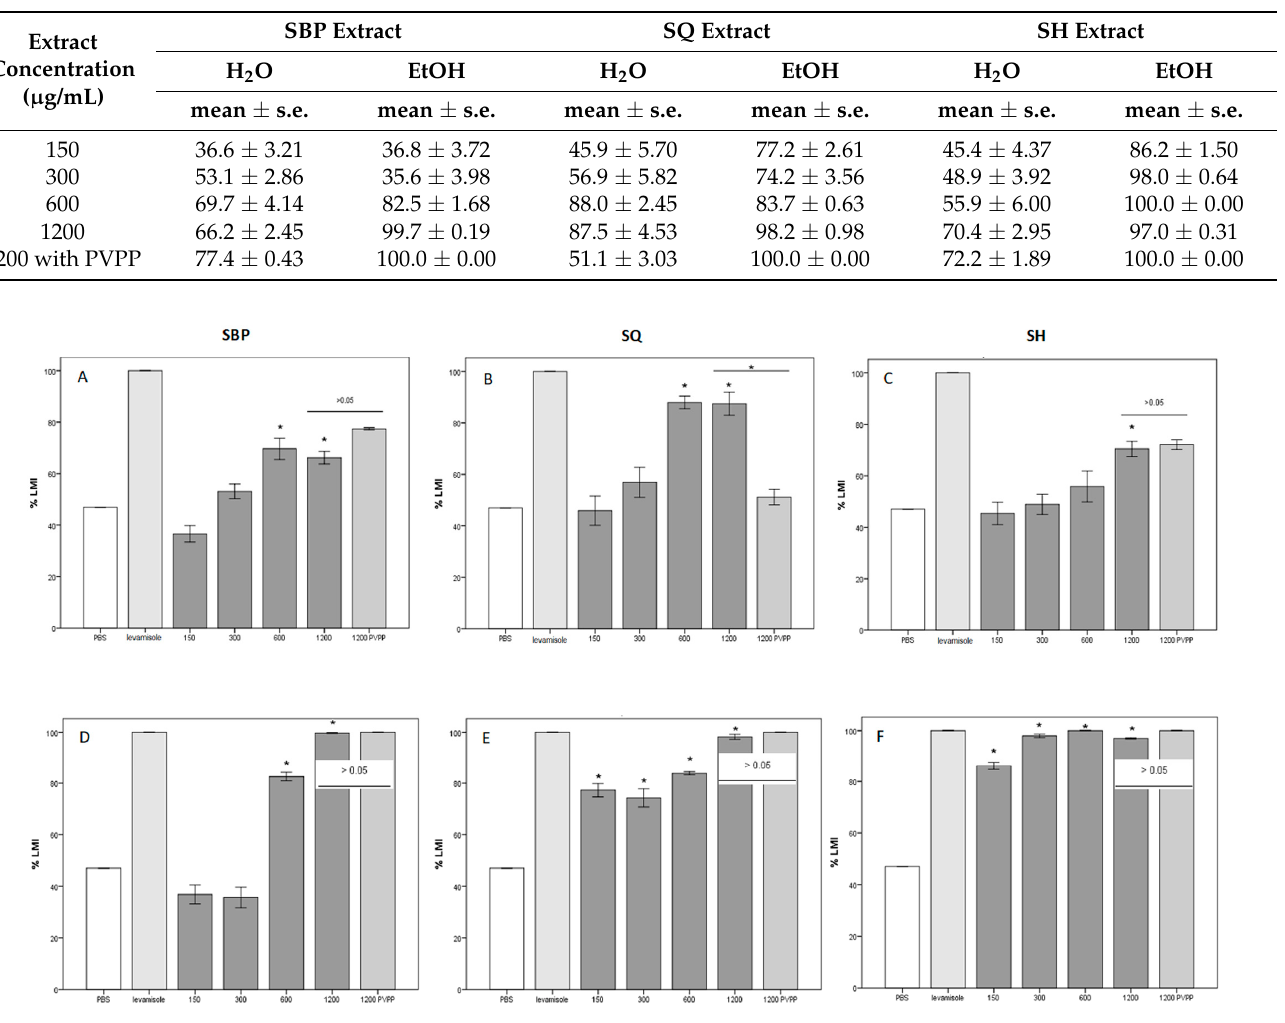
Table 2. Descriptive data obtained with the Larval Migration Inhibition Test (LMIT) on the three products tested (extract concentrations: 150, 300, 600, and 1200 µ g/mL, 4 replicates) and on the concentration 1200 µ g/mL with the addition of PVPP (tested in 3 replicates). The mean counts relating to the third stage larvae (L3) which actively migrated and those obtained for the replicates are reported. PVPP: polyvinylpolypyrrolidone; H 2 O: water extract; EtOH: ethanol extract; SBP: Silvafeed BYPRO; SQ: Silvafeed Quebracho powder; SH: Sainfoin hay; s.e.: standard error.